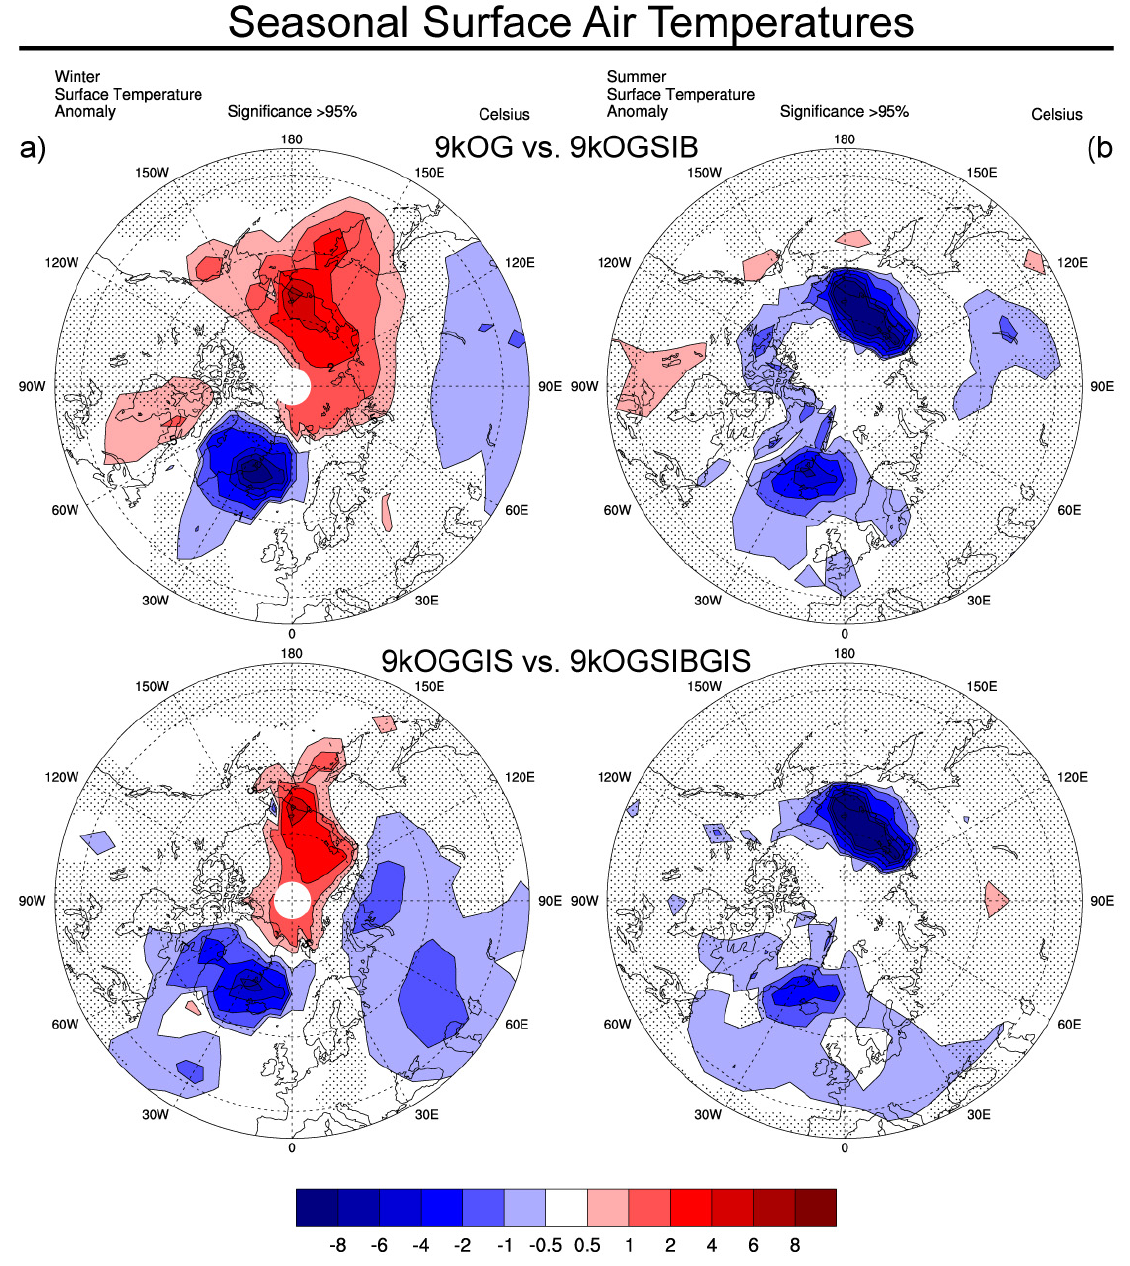
Fig. 6. Seasonal surface temperature anomalies of simulation 9kOG as compared to 9kOGSIB (upper panel) and simulation 9kOGGIS as compared to 9kOGSIBGIS (lower panel). Winter is DJF ( a ), Summer is JJA ( b ). Shaded area denotes insignificant changes compared to 9kOGSIB or 9kOGSIBGIS according to a Student t